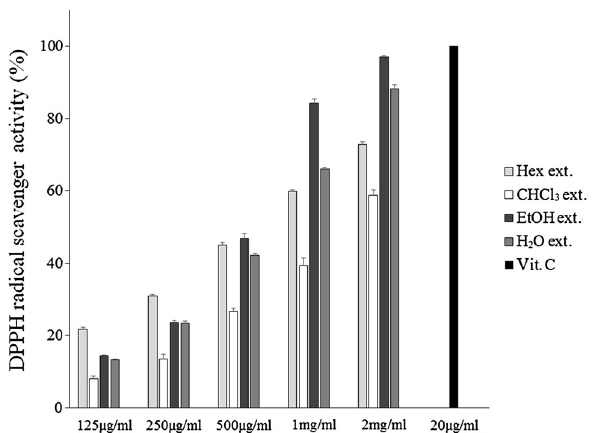
Fig. 7 Antioxidant activity of sequential solvent extracts from B. napus . Antioxidant activity was evaluated by measuring reduction in DPPH radical detected at 517 nm. Vitamin C was used as a positive control. Results are expressed as the mean ± SD of three independent